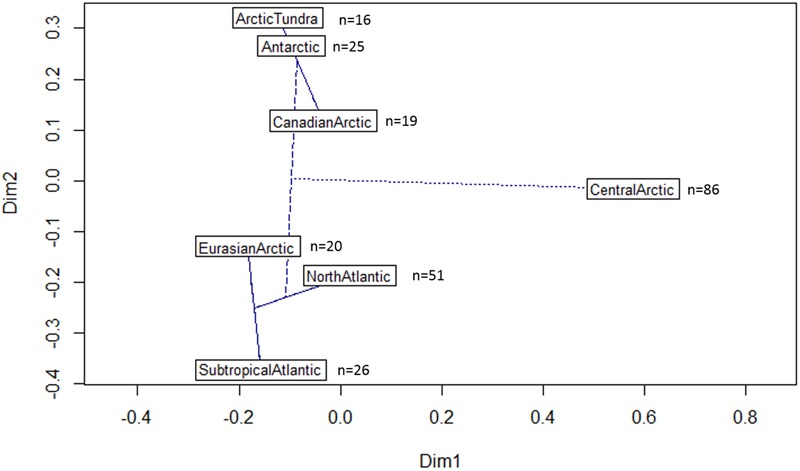
Dissimilarities between different oceanic regions based on their nifH phylogenetic signature. Plot of the first two principal coordinate axes of the Principal coordinates analysis (PCoA) derived from the Unifrac distances between different oceanic regions included in the maximum likelihood tree (Figure 6). The further away the samples are, the more dissimilar they are in terms of nifH phylogenetic signature. An automatic correction for negative eigenvalues was used. A cluster dendrogram is superimposed. The lines indicate the strength of the dissimilarity. Oceanic regions connected with a solid line have a dissimilarity less than 0.69 (Supplementary Table S2). The dashed line indicates a dissimilarity of 0.76 and the doted line between the Central Arctic and the subtropical Atlantic indicates the maximum dissimilarity of 0.85 (Supplementary Table S2). The number of representative sequences (97% nucleotide identity) from each oceanic region included in the analysis is indicated next to the region’s name.